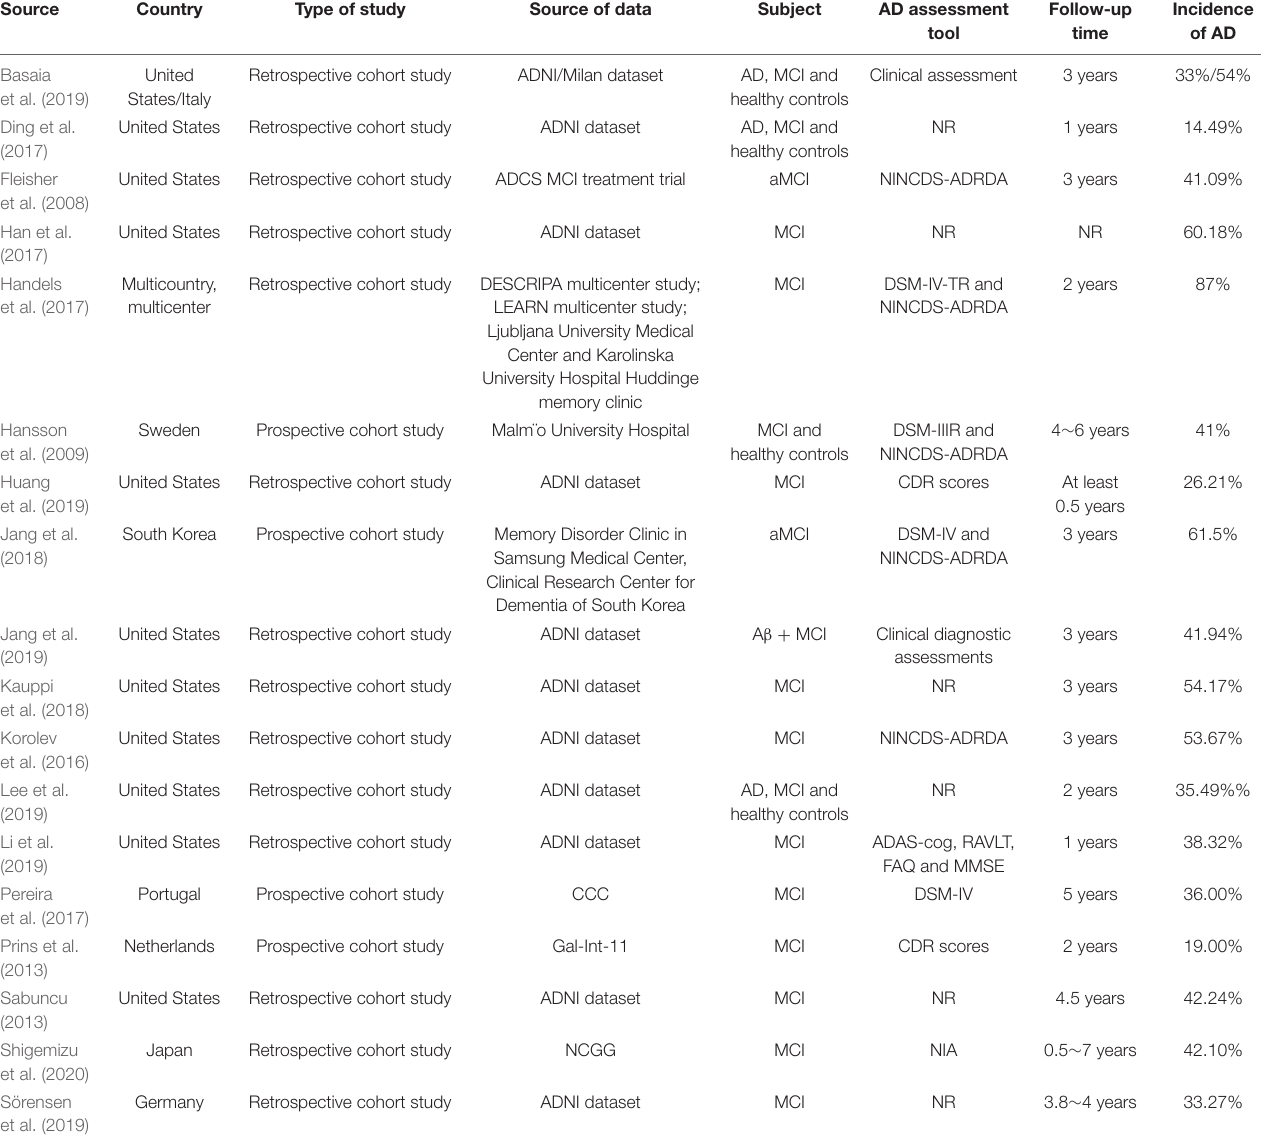
TABLE 1 | Primary characteristics of the prediction model included in the review ( n =